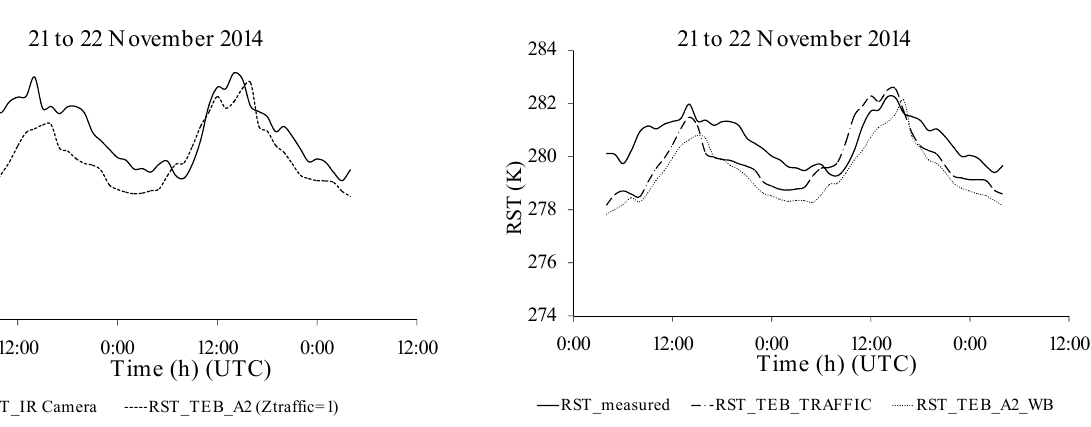
Figure 11. Comparison between RST measured by the IR camera in an area impacted by traffic and RST from TEB via the second approach with Z traffic = 1 for the first experiment.